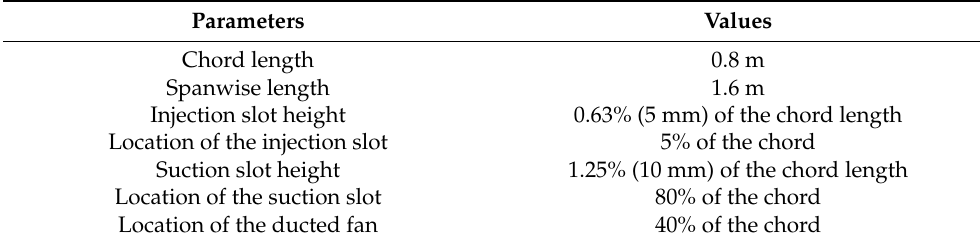
Table 1. Detailed parameters of DCFJ312 and CFJ312 airfoils.